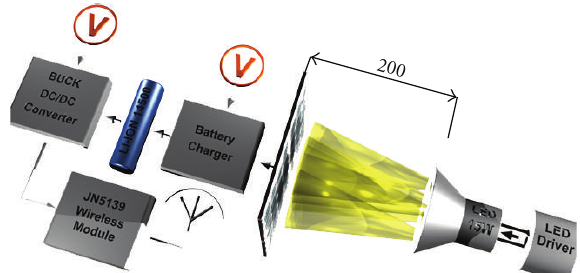
Figure 6: The block diagram of test equipment in the laboratory